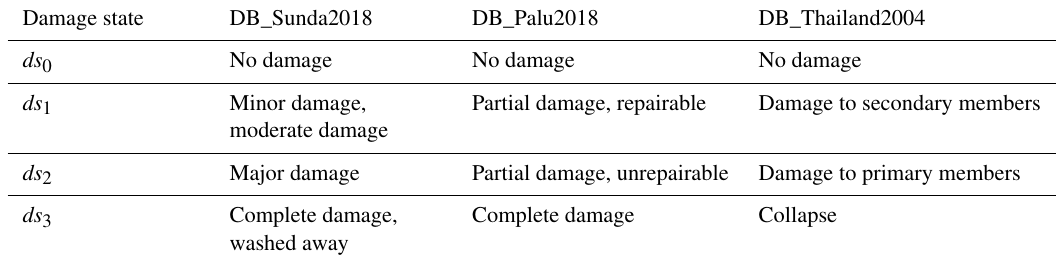
Table 1. Harmonization between the different damage scales used in DB_Sunda2018, DB_Palu2018, and DB_Thailand2004. Damage state DB_Sunda2018 DB_Palu2018 DB_Thailand2004 ds 0 No damage No damage No damage ds 1 Minor damage, Partial damage, repairable Damage to secondary members moderate damage ds 2 Major damage Partial damage, unrepairable Damage to primary members ds 3 Complete damage, Complete damage washed away